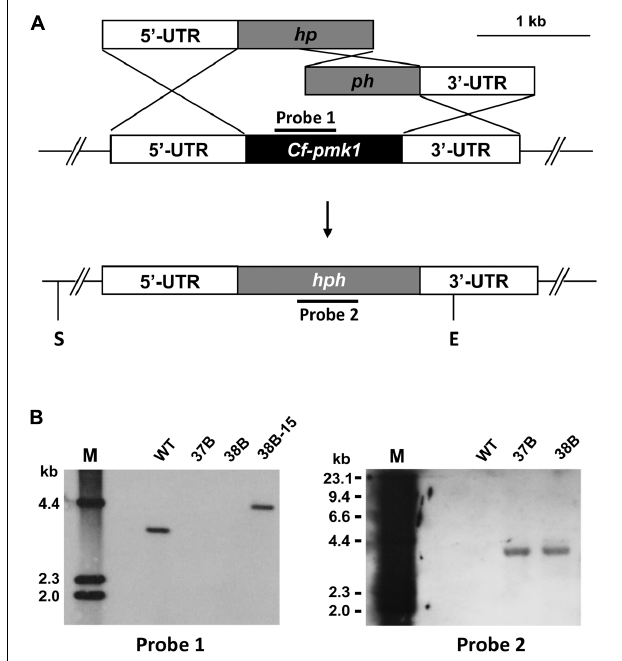
FIGURE 2 | Generating gene deletion mutants of the CfPMK1 gene. (A) CfPMK1 gene locus and gene replacement constructs. S, Sal I; E, Eco RV. (B) Southern blot of Sal I/ Eco RV digested genomic DNA hybridized with probe 1 (left) and probe 2 (right).